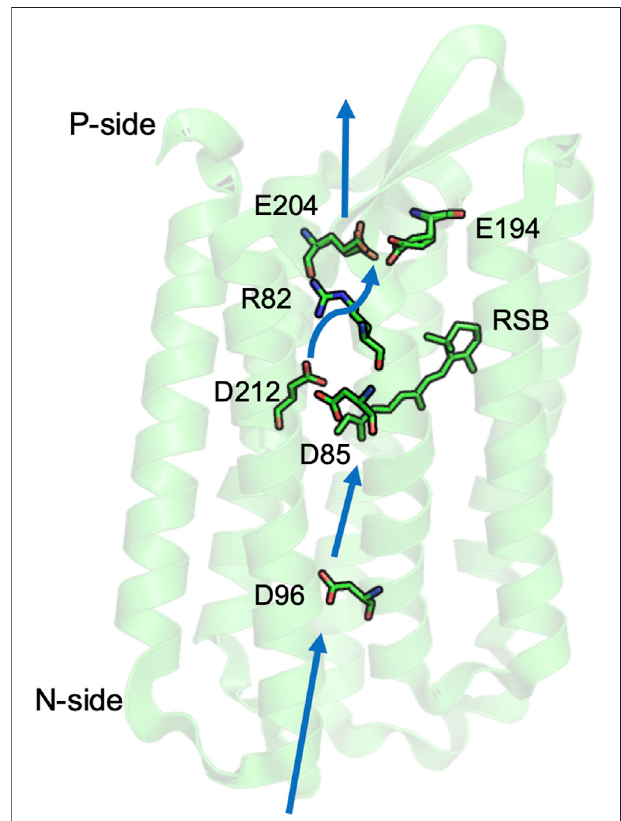
FIGURE2| Key residues forproton transferin bacteriorhodopsin.Three separatedPLSare:theisolatedD96;thecentralclusterD85,D212,andretinal Schiff base (RSB); and the exit cluster E194 and E204. Movement of R82 stabilizes unloading the central or exit clusters. Blue thick arrows show direction of proton transfer from N- to P-side by water mediated proton transferpaths. Thecoordinatesfor Halobacterium salinarum bRarefrom PDB ID: 5ZIM (Hasegawa et al.,